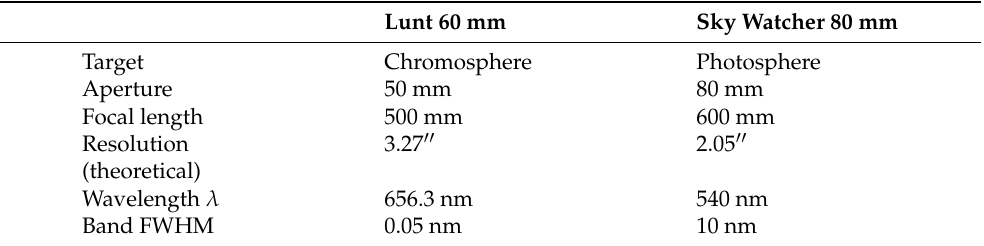
Table 1. SUTO-Solar telescopes.